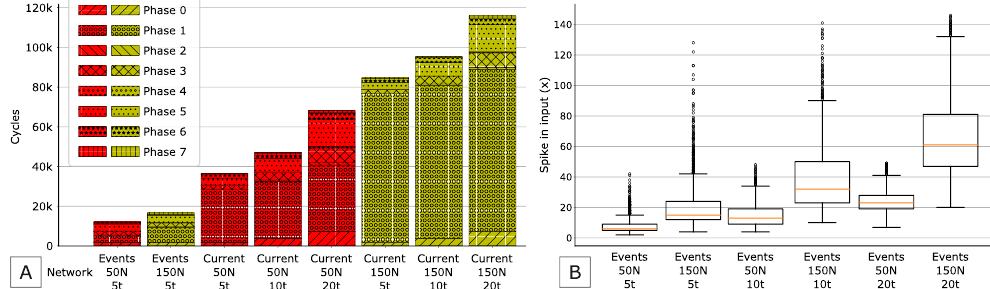
Figure 11. ( A ) cycle count breakdown for the event-driven (event) and current-driven (current) eLSNN best configurations (input number-inference ticks) computed on median activity conditions. ( B ) Distribution of the spikes in input for the event-driven eLSNN with different configurations (input number-inference